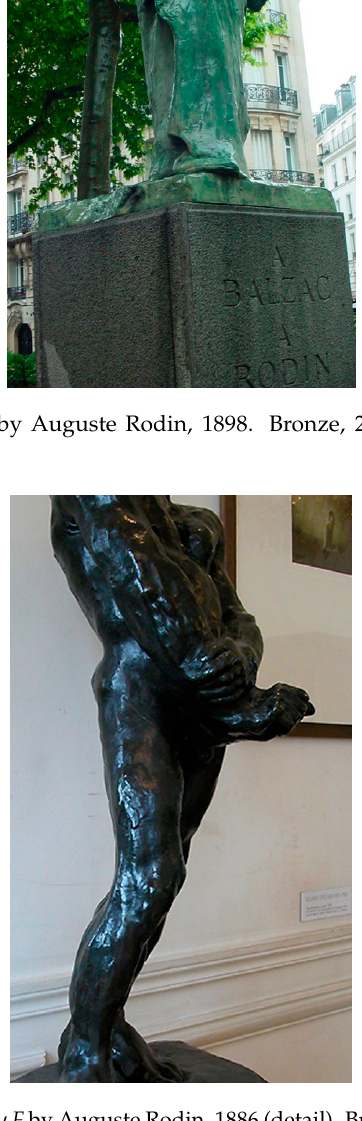
Figure 4. Balzac, second nude study F by Auguste Rodin, 1886 (detail). Bronze, 93.1 cm × 43.5 cm × 35 cm. Musée Rodin , Paris. Photo by the author.